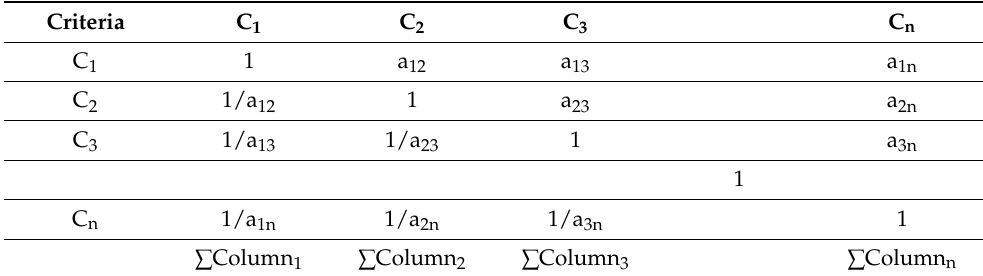
Table 1. Development of the pairwise comparison matrix